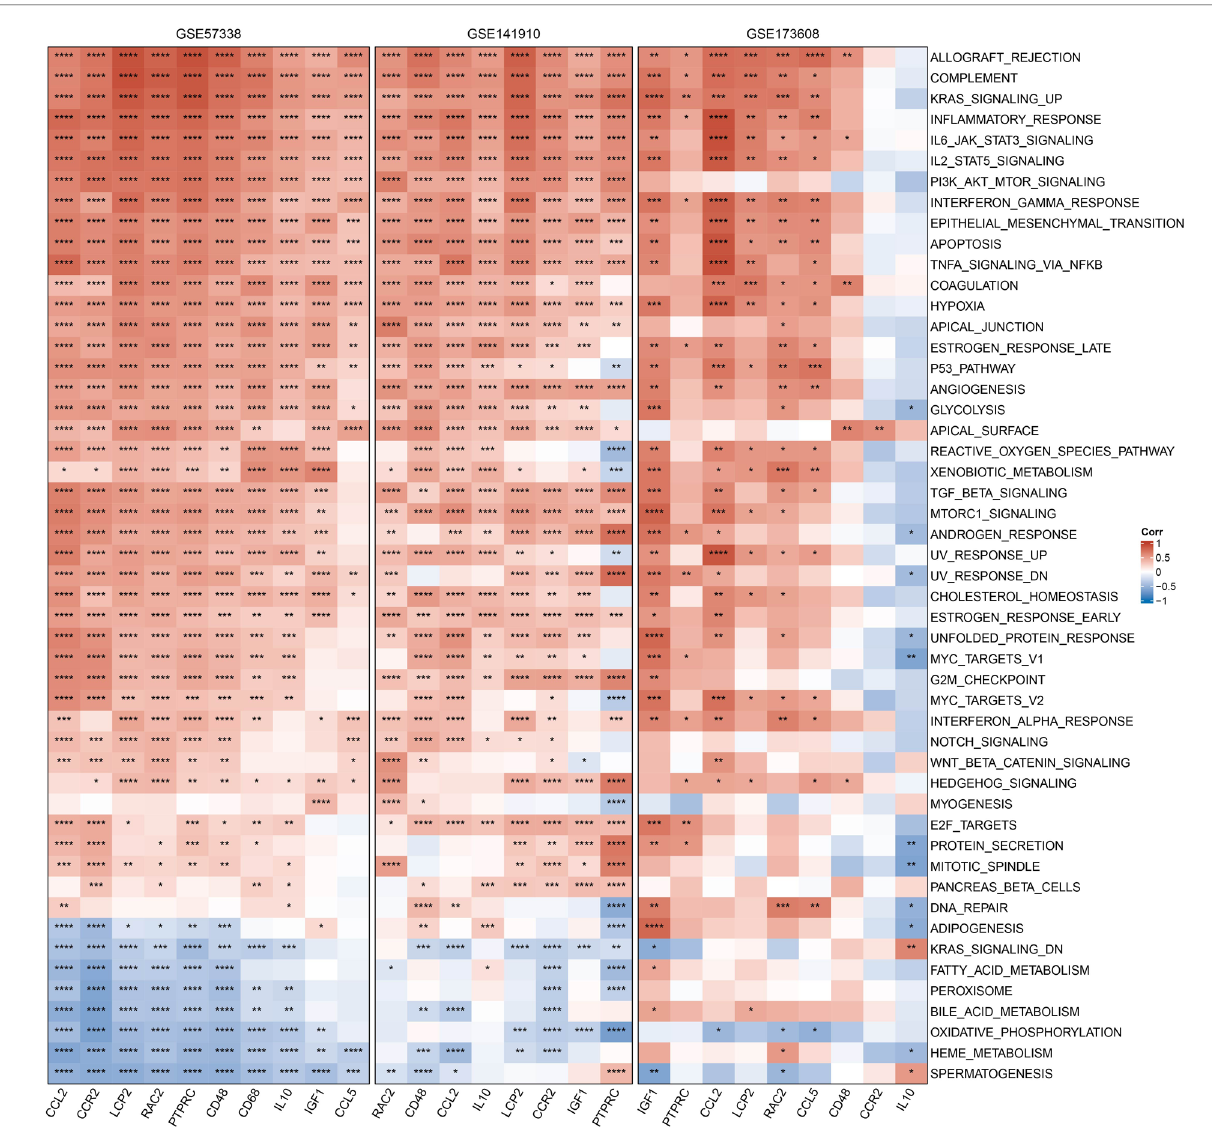
FIGURE 8 Correlation between hub genes and pathways, red represents positive correlation, blue represents negative correlation, * p <0.05, ** p <0.01, *** p <0.001, **** p <0.0001.